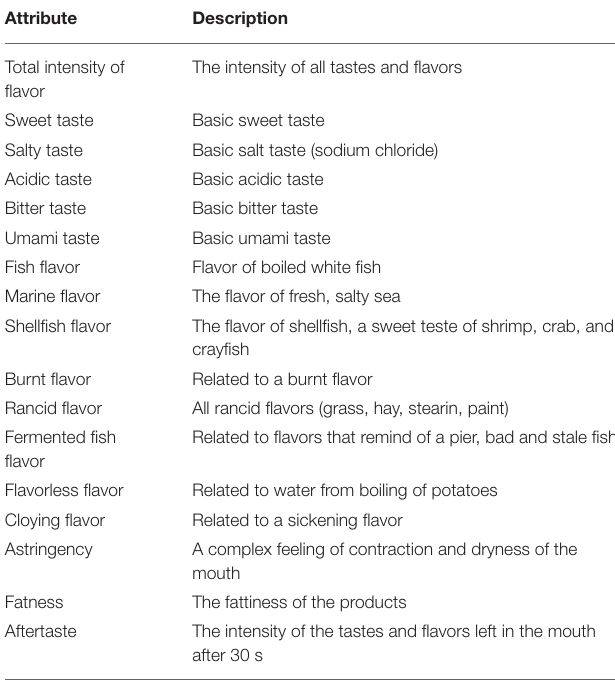
TABLE 1 | The sensory attributes used in the sensory evaluation of salmon, mackerel, and herring protein hydrolysates.